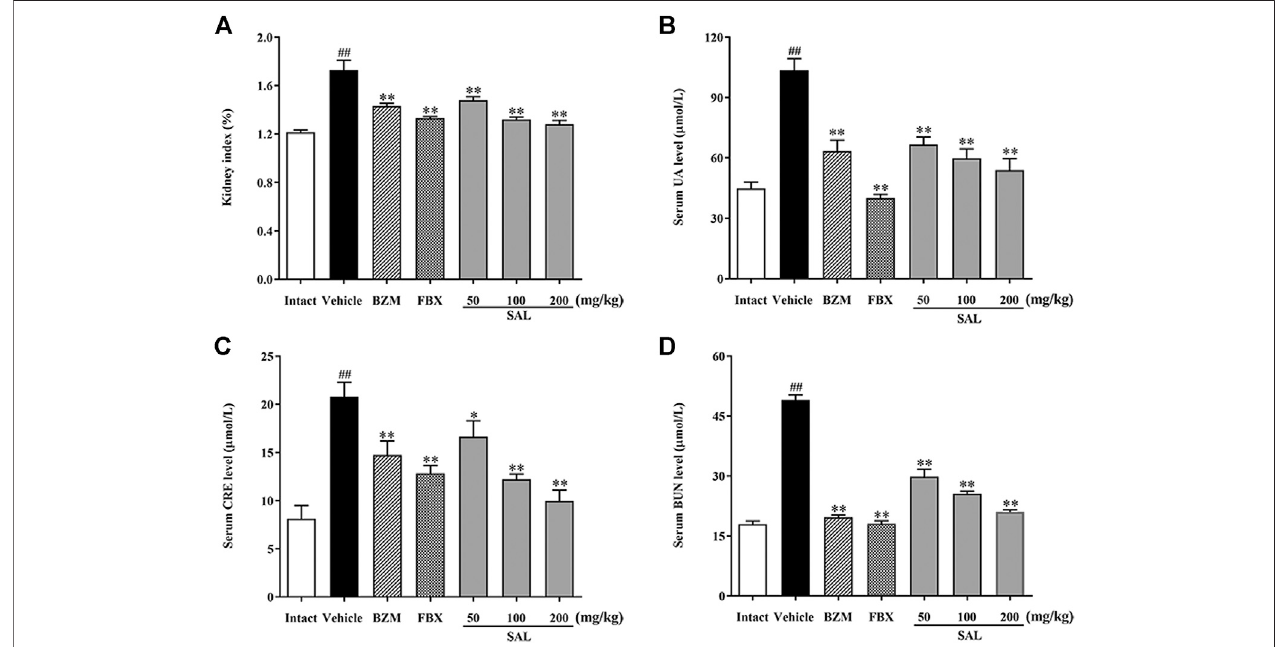
FIGURE 3 | Effect of SAL on the levels of UA, CRE, and BUN in serum. (A) Kidney index; level of (B) UA; (C) CRE; (D) BUN in serum. All data are expressed as mean ± SD ( n (cid:2) 8). ## p < 0.01 vs. the intact group, *p < 0.05, **p < 0.01 vs. the vehicle group.